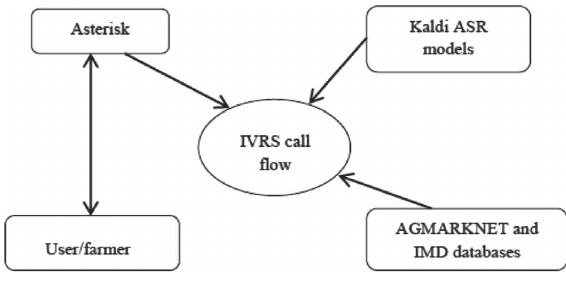
Figure 2: An Integration of ASR System and